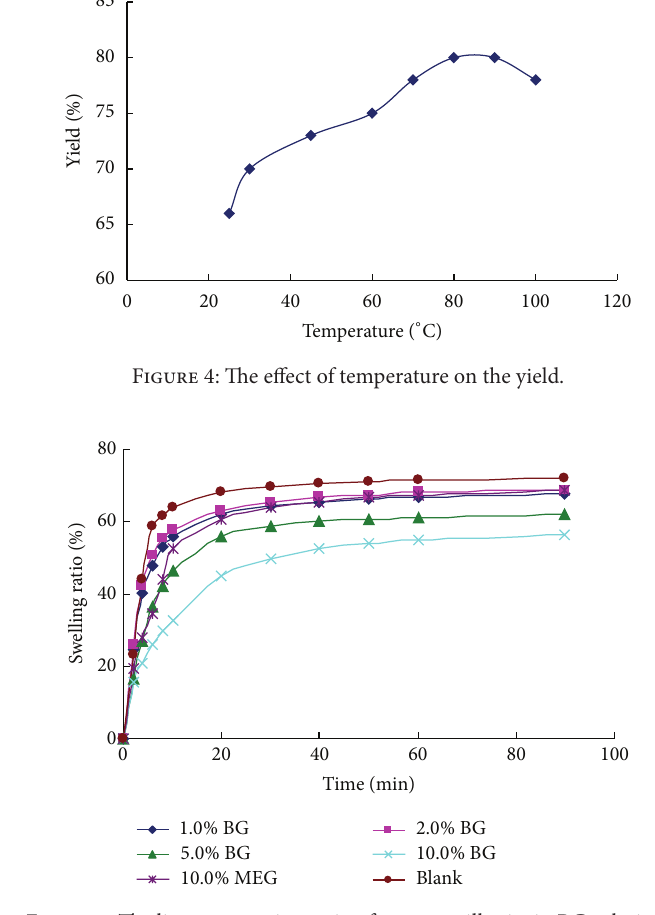
Figure 5: The linear expansion ratio of montmorillonite in BG